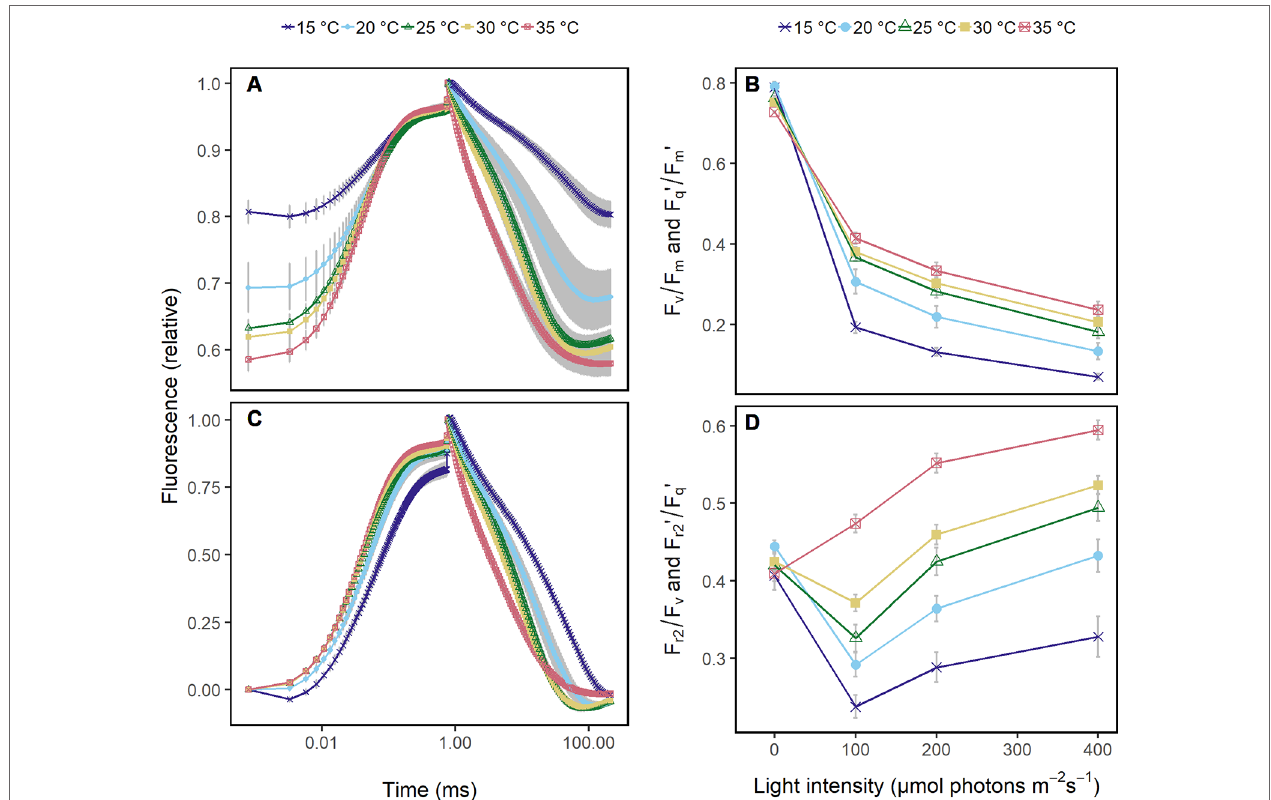
FIGURE 1 | Chlorophyll fluorescence transients were acquired in Arabidopsis leaves from 60 cm distance using fast repetition rate excitation flashlets. Leaves were subjected to different temperatures (15 to 35°C) and different light intensities under controlled laboratory conditions. (A) Transient was normalized to the maximum chlorophyll fluorescence which allows to compare the quantum efficiency of the photosystem II (F v /F m in the dark and F q '/F m ' in the light) at the different temperatures. The ambient light intensity was 200 μmol photons m −2 s −1 . (B) F v /F m and F q '/F m ' in response to increasing light intensities at the different temperatures are shown. (C) Chlorophyll fluorescence transients in (A) were double normalized to the maximum and minimum chlorophyll fluorescence, which allows to retrieve the efficiency of electron transport 5 ms after reduction of the primary quinone (Q A ) (F r2 /F v in the dark, F r2 '/F q ' in the light). (D) F r2 /F v and F r2 '/F q ' are shown in response to increasing light intensities at the different temperatures. Attached Arabidopsis leaves (n = 6) were measured in dark-adapted and steady-state at 0, 100, 200, and 400 μmol photons m −2 s −1 of blue light (445 nm). Error bars indicate the 95% confident